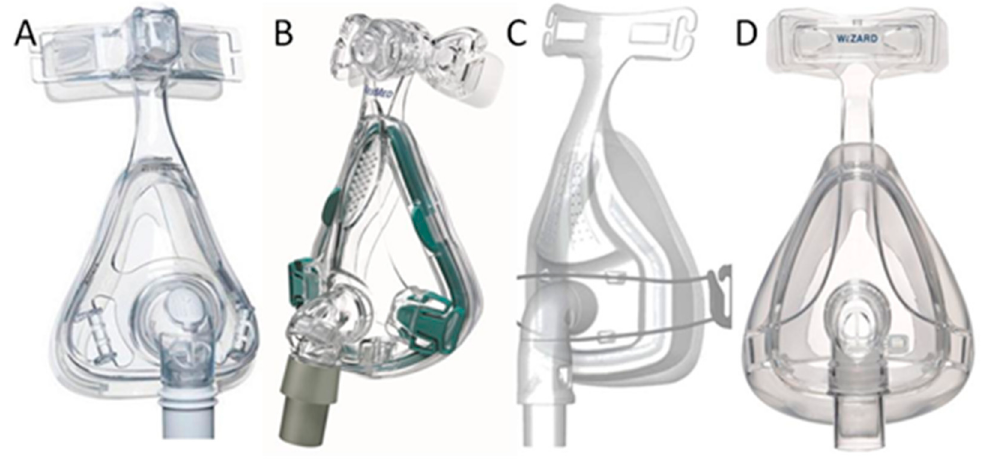
Figure 1. Appearance of the four masks: ( A ) Amara mask, ( B ) Mirage Quattro mask, ( C ) Forma mask, and ( D ) Wizard mask.